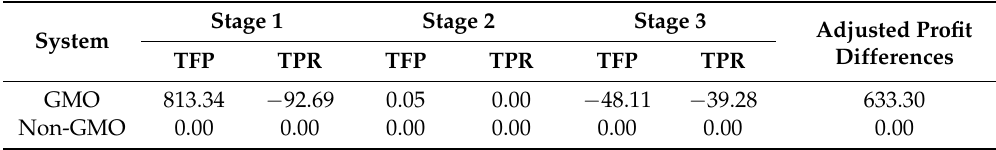
Table 10. Differences in the adjusted profit for GMO and non-GMO systems if the quantity for Non-GMOs is raised